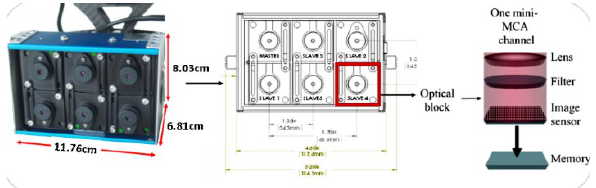
Fig 2. Micro MCA Tetracam